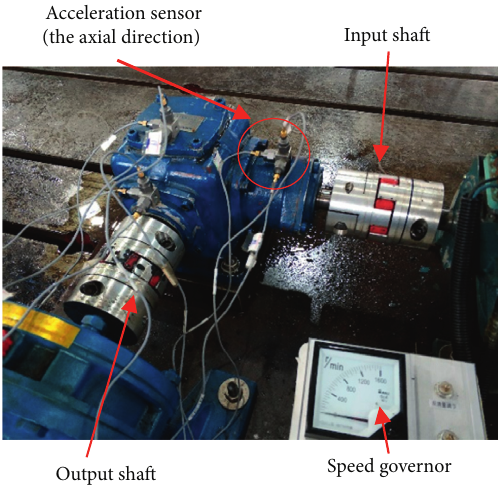
Figure 3: The spiral bevel gearbox test equipment.